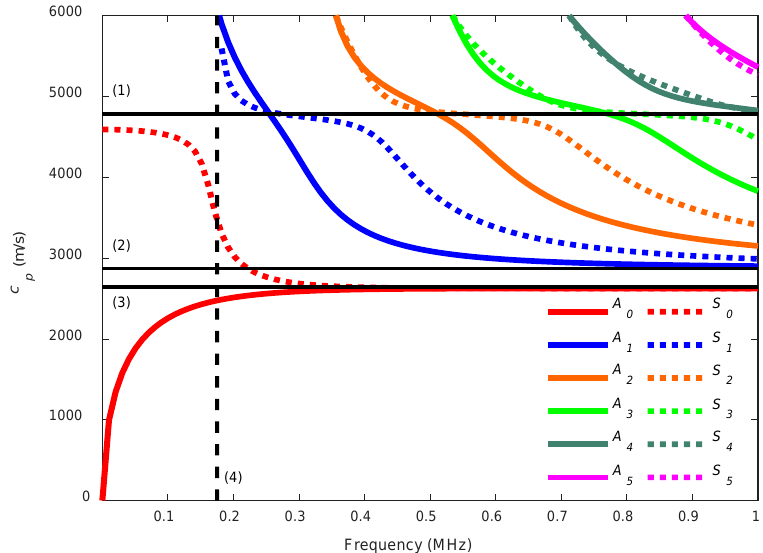
Figure 2. An example of Lamb wave phase velocity dispersion curves for a mortar plate ( c L = 4779 m / s, c T = 2872 m / s, 2 h = 13 mm). The three non-dispersive velocities (longitudinal ( 1 ), shear ( 2 ) and Rayleigh ( 3 ) wave velocities, continuous lines) and the first cut-off frequency ( 4 ) (discontinuous line) are highlighted. Antisymmetric modes are represented by solid lines and symmetric modes are represented by dotted lines.